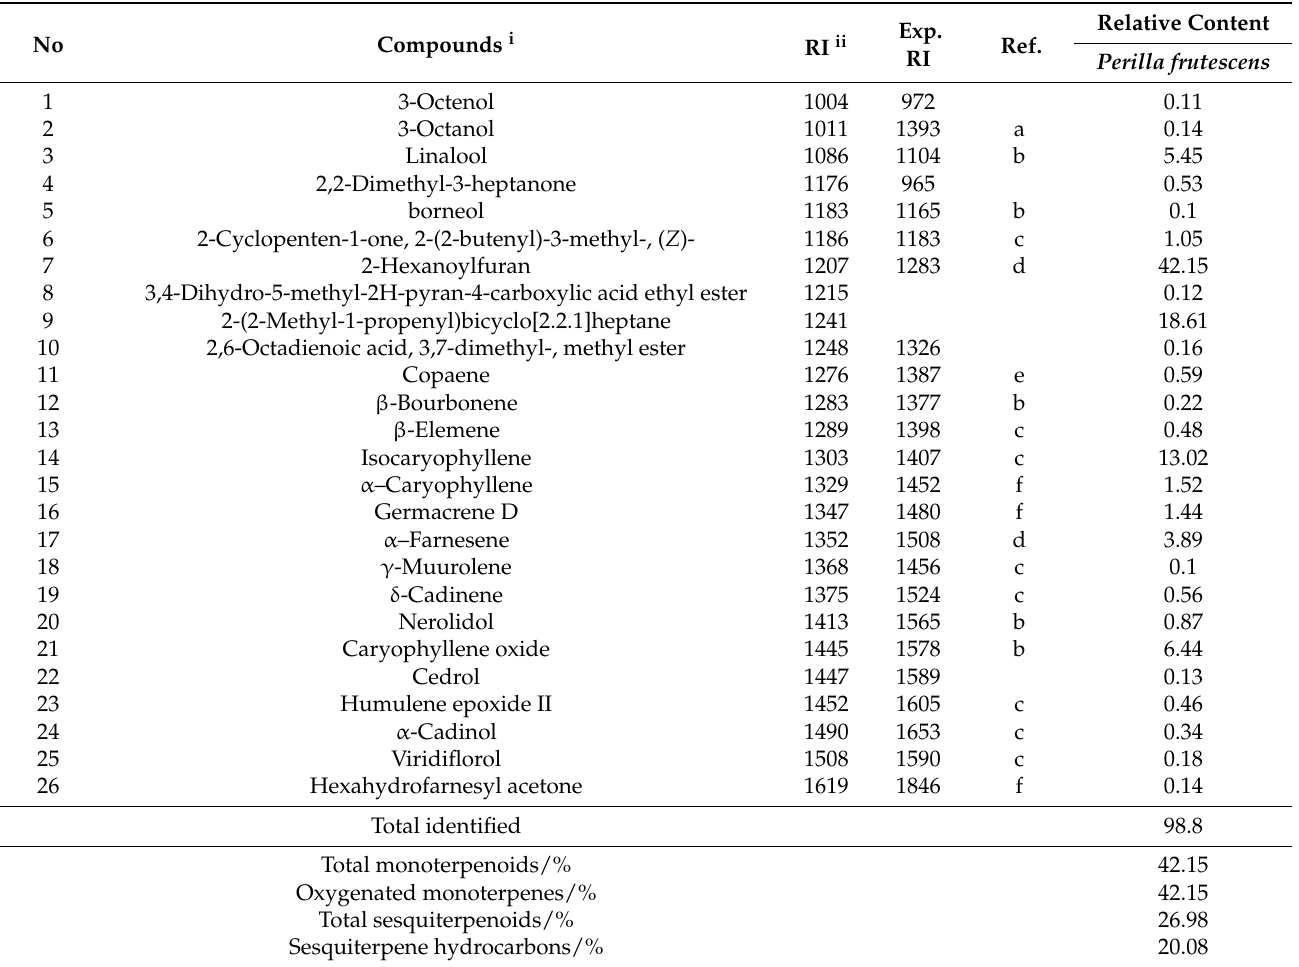
Table 2. Retention Index (RI) and relative content (%) of chemical compositions identified from Perilla frutescens essential